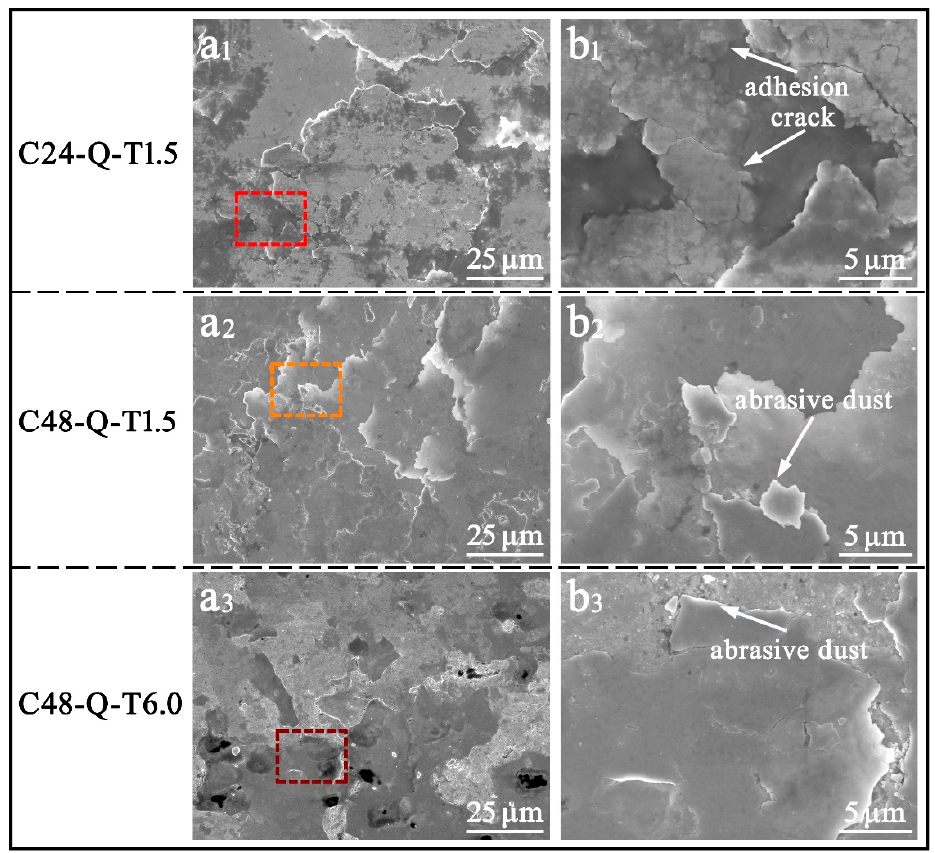
Figure 4. SEM images of the worn surface of the specimens processed with different carburiz- ing/tempering durations; ( b 1 – b 3 ) is the magnified map of the selected region in ( a 1 – a 3 ). ing/tempering durations; ( b1 – b3 ) is the magnified map of the selected region in ( a1 – a3